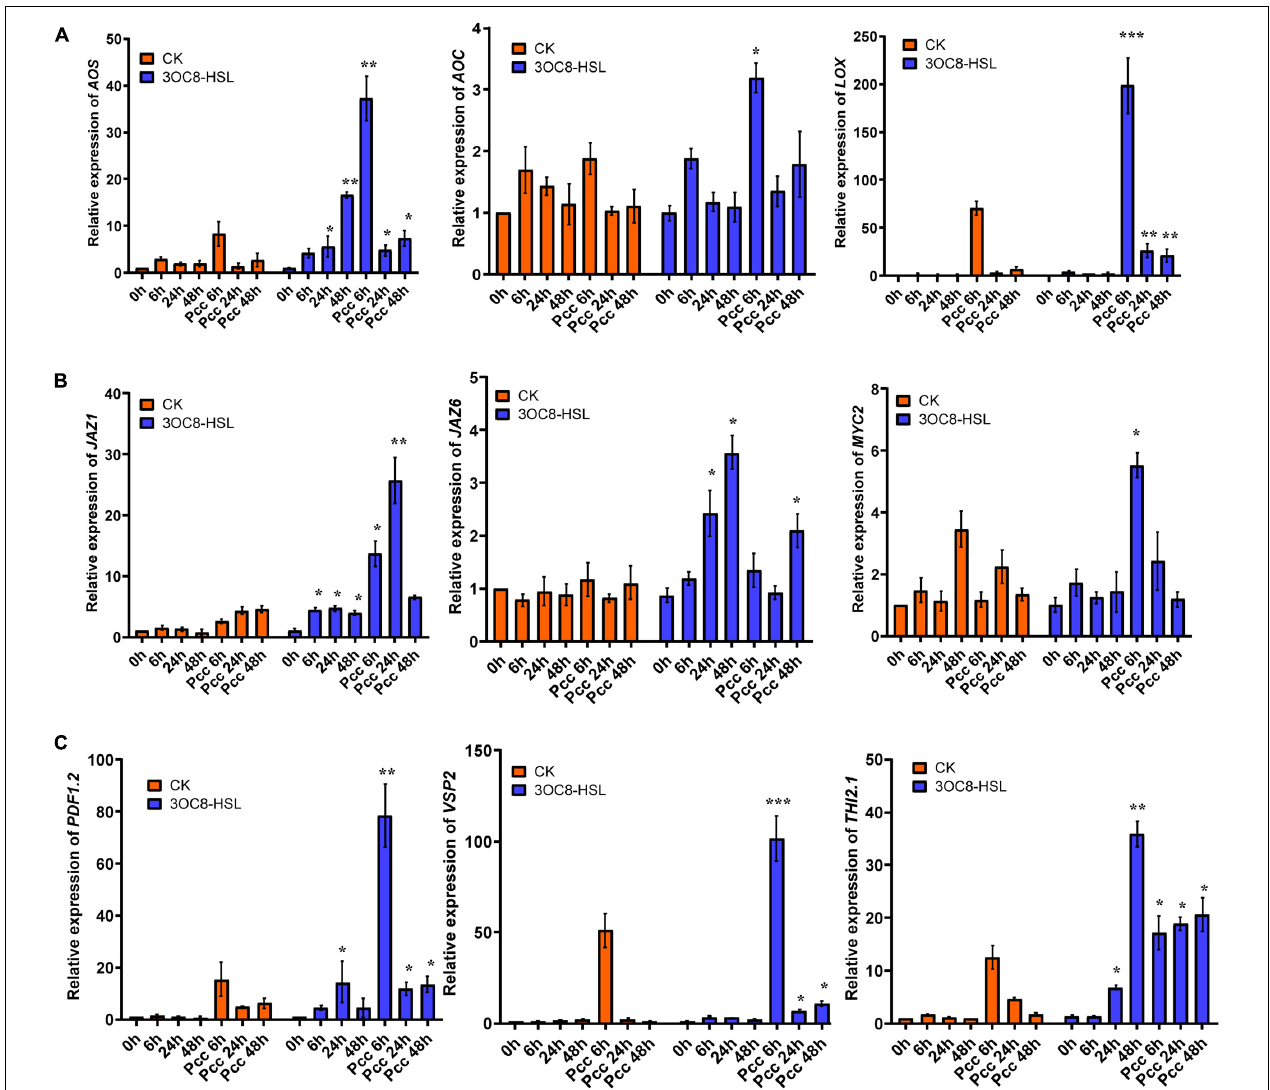
FIGURE 2 | Expressions of the JA-related genes in Arabidopsis plants pretreated with 3OC8-HSL and challenged with Pcc . (A) Expressions of JA synthesis genes AOS , AOC , and LOX . (B) Expressions of JA pathway transcriptional regulators genes JAZ1 , JAZ6 , and MYC2. (C) Expressions of JA downstream cascade genes PDF1.2 , VSP2 , and Thi2.1 . At least five independent experiments were performed, each of which with three technical repeats. Total RNA was extracted from Arabidopsis Col-0 seedlings pretreated with 10 µ M 3OC8-HSL at the roots for 48 h followed by Pcc inoculation. Samples were collected at the indicated time points (hpi). Real-time PCR was performed using gene-specific primers, and the relative expression levels of the induced resistance marker genes are shown. Values are means ± SD of five independent experiments. Asterisks indicate a statistically significant difference between the AHL-pretreated and the water-treated plants (ANOVA test, * P < 0.05; ** P < 0.01, *** P <